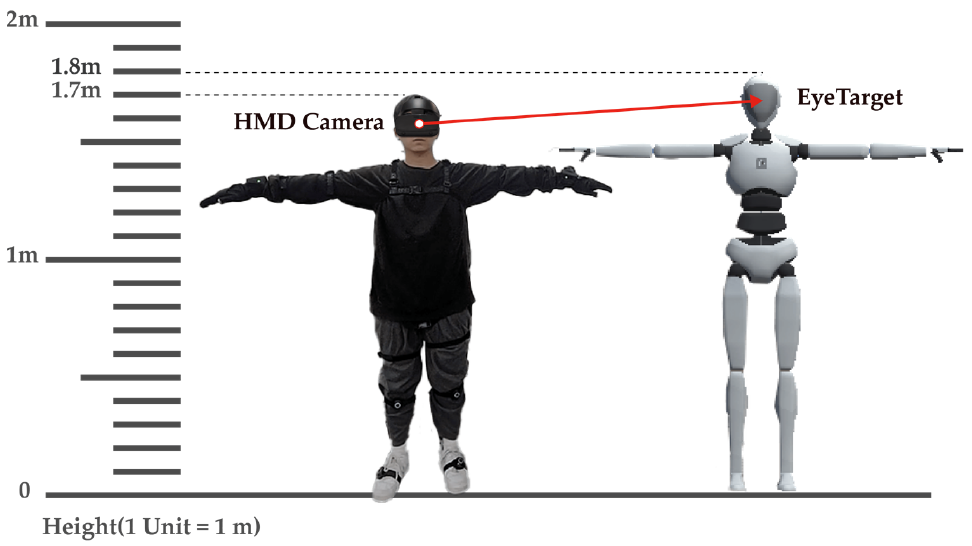
Figure 9. Existing character size synchronization method.